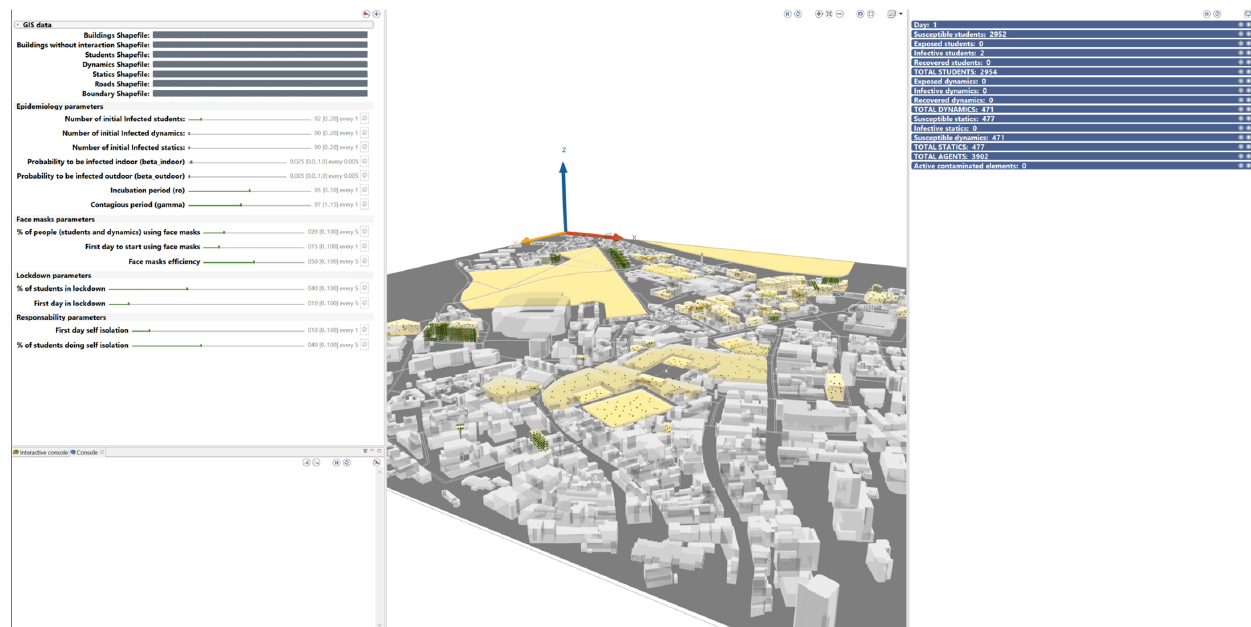
Figure 12. Screenshot of the ABM GUI. Contains Ordnance Survey data © Crown copyright and database right 2020.